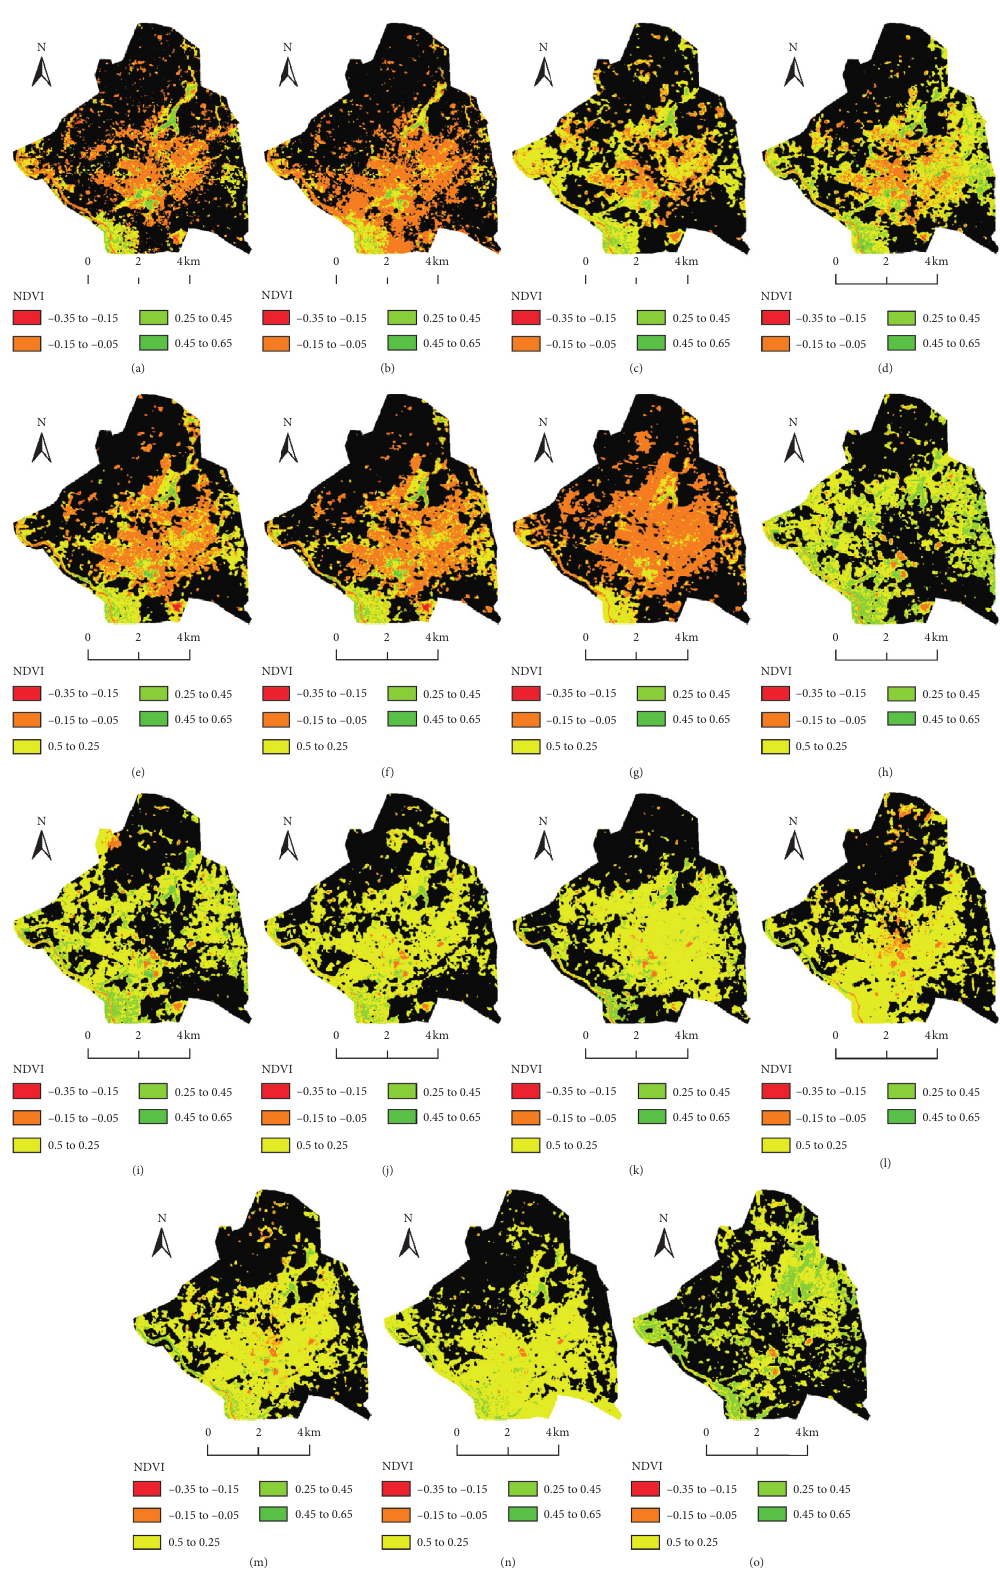
Figure 8: NDVI in the area below mean LST: (a-b) 2002, (c-d) 2006, (e–g) 2010, (h–k) 2014, and (l–o) 2018. The black portion of the maps shows the area above mean